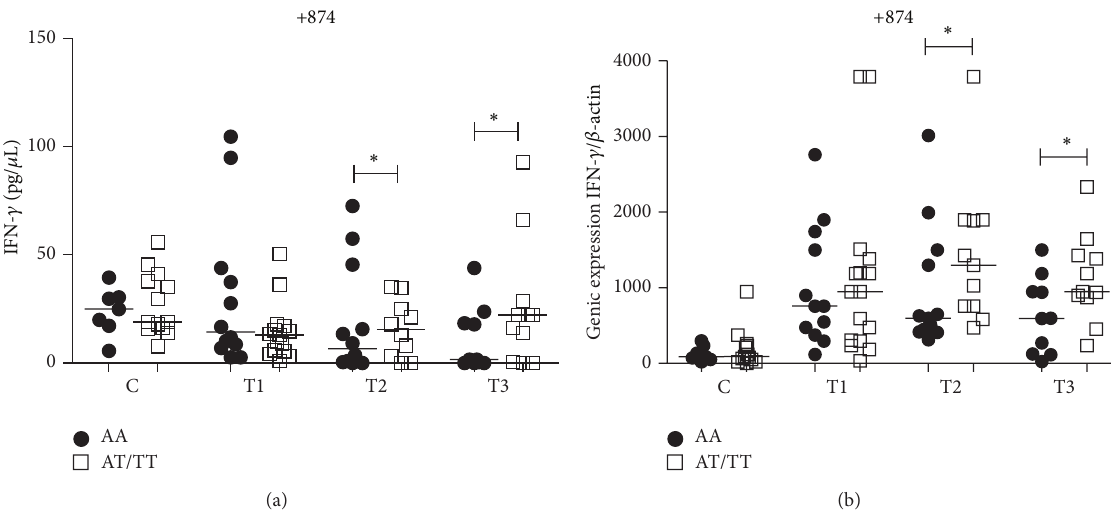
Figure 1: Influence of IFNG +874T/A gene SNP on IFN- 𝛾 plasma levels (a) and mRNA expression (b) in the control group (C) and PTB patients group at three time points of the treatment: T1 (after diagnosis and first month), T2 (three months), and T3 (six months). Data are shown as median levels. ∗ 𝑃 < 0.05